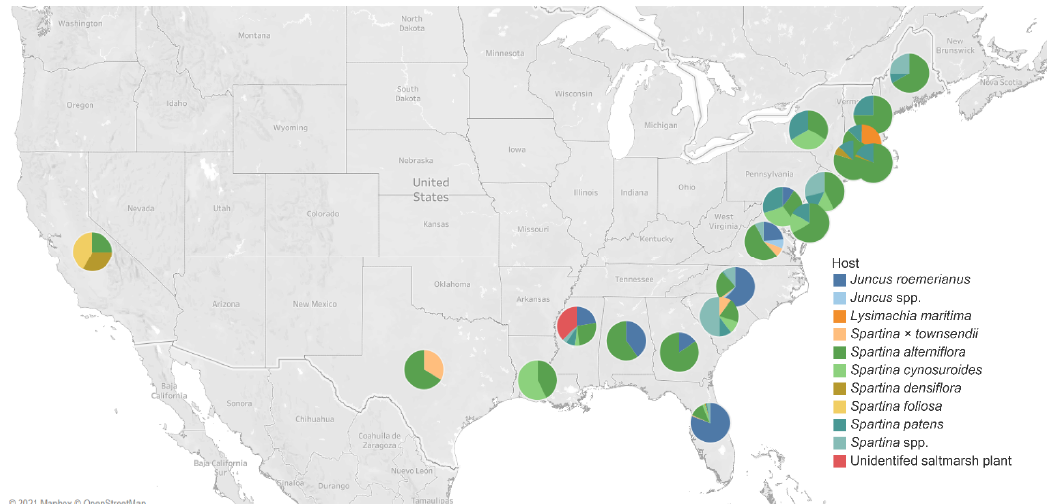
Figure 16. Map of the United States of America (USA) showing the distribution of fungal diversity studies of halophytes in different states. The different color of each pie chart represents the hosts, and the angle measured the number of their fungal associates.